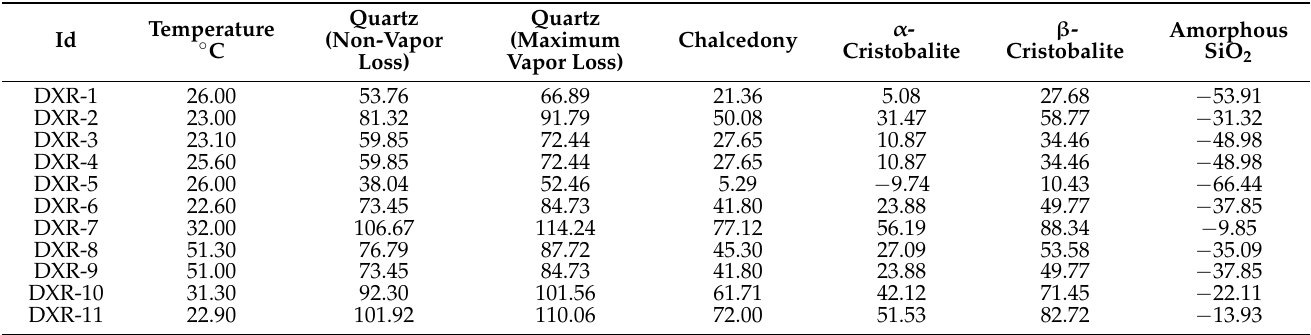
Table 6. The SiO 2 geothermometer calculates the heat storage